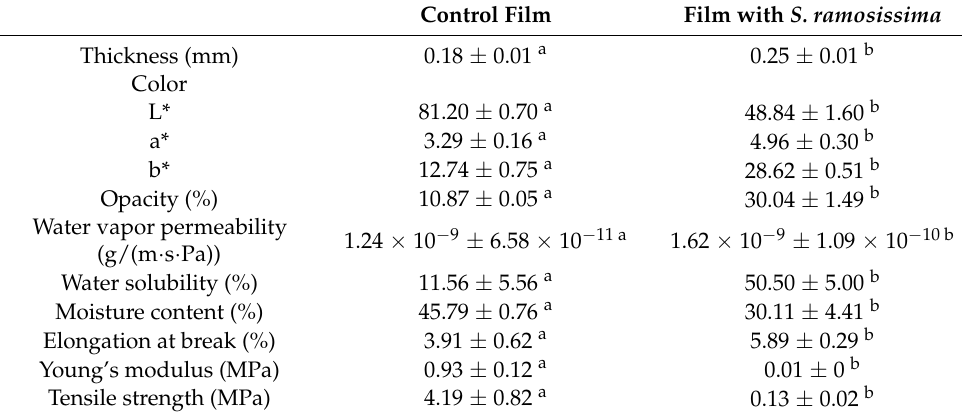
Table 1. Physico-mechanical parameters of the developed films.